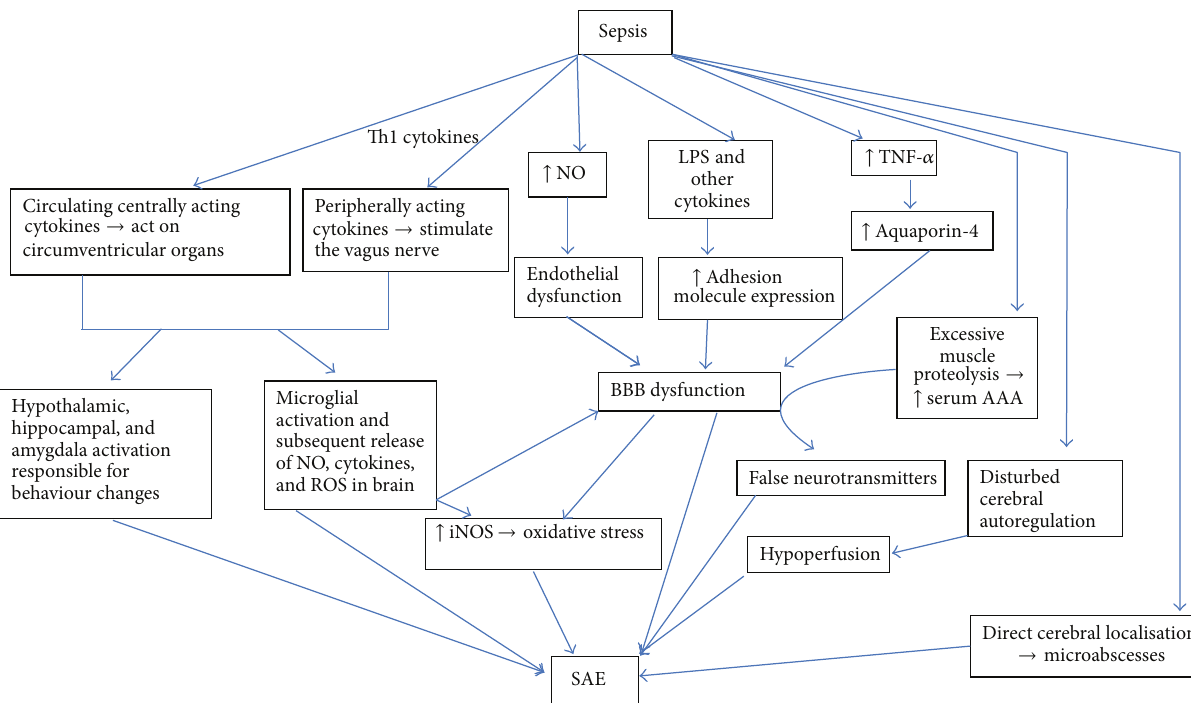
Figure 1: Pathophysiology of sepsis associated encephalopathy. Altered brain signalling during sepsis occurring as a result of centrally and peripherally acting cytokines results in production of various inflammatory cytokines that cause activation of various behavioral, neuroendocrine, and neurovegetative centers which can cause altered behaviour. In addition these cytokines cause microglial activation thus perpetuating the production of inflammatory cytokines and reactive oxygen species. Peripherally produced LPS, cytokines, and NO cause further damage to the BBB thereby causing a vicious cycle of brain damage. The excessive production of LPS and cytokines causes increased production of NO and other ROS thereby causing mitochondrial dysfunction and apoptosis. Altered amino acid balance because of excessive muscle proteolysis is responsible for production of false neurotransmitters which can also contribute to the pathogenesis of SAE. Disturbed cerebral autoregulation and direct cerebral localization may play a minor role. NO: nitrous oxide, ROS: reactive oxygen species, LPS: lipopolysaccharide, TNF- 𝛼 : tumor necrosis factor- 𝛼 , AAA: aromatic amino acids, and BBB: blood brain